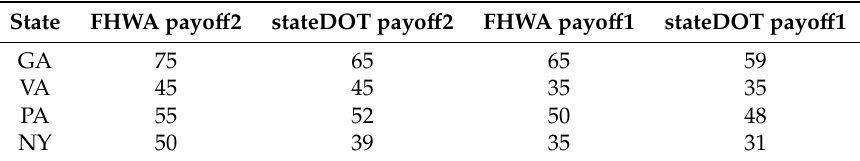
Figure 3. Game tree illustrating a strategic move and payoffs of two players in Georgia. Table 1. Payoffs (years) of the strategic moves.